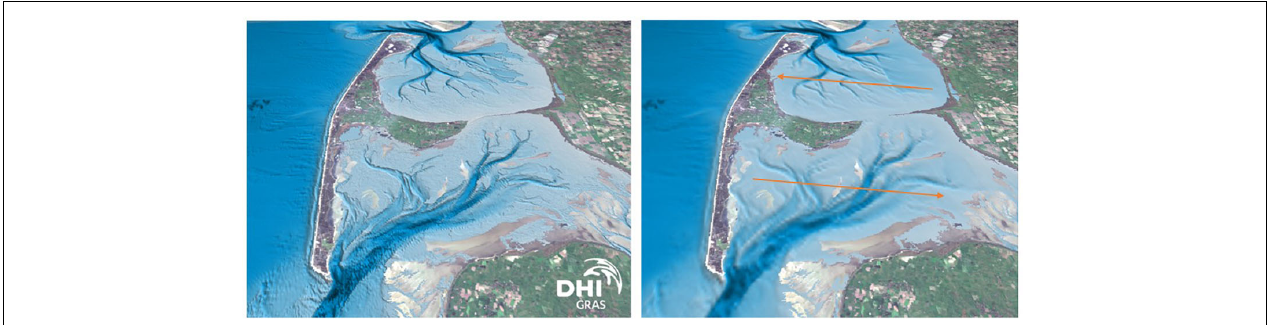
FIGURE 4 | Illustration of the higher level of detail resulting from a S2 derived bathymetry (left) when compared to the widely used EMODnet bathymetry (right) . The example shown is from the German part of the Wadden Sea, inside the corresponding CEASELESS pilot